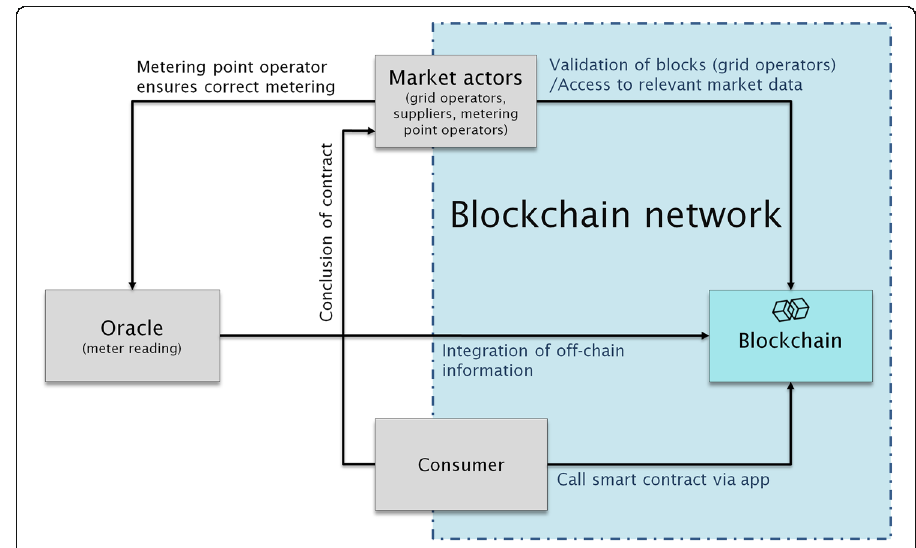
Fig. 2 Schematic representation of a mapping-based